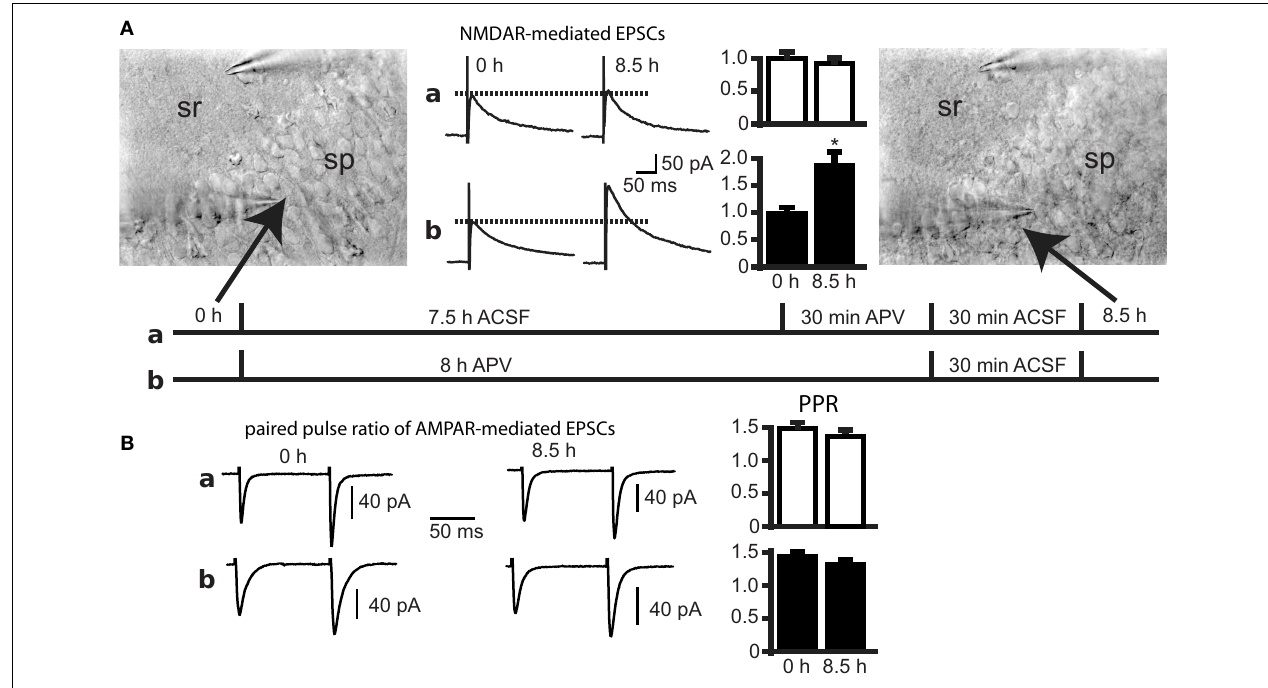
FIGURE 7 | APV treatment increases synaptic NMDAR-mediated EPSCs in CA1 neurons of acute hippocampal slices. (A) Synaptic EPSCs were evoked in hippocampal slices by stimulation of Schaffer collateral/commissural fi bers. EPSCs were recorded in adjacent pyramidal cells at a holding potential of + 40 mV. Control slices (condition a) were incubated in ACSF for 7.5 h, followed by 30 min ACSF + APV (APV) and an APV-free ACSF-step for 30 min prior to recording. This treatment did not change the EPSC amplitude. In contrast, 8 h of APV treatment (condition b) induced an increase in the